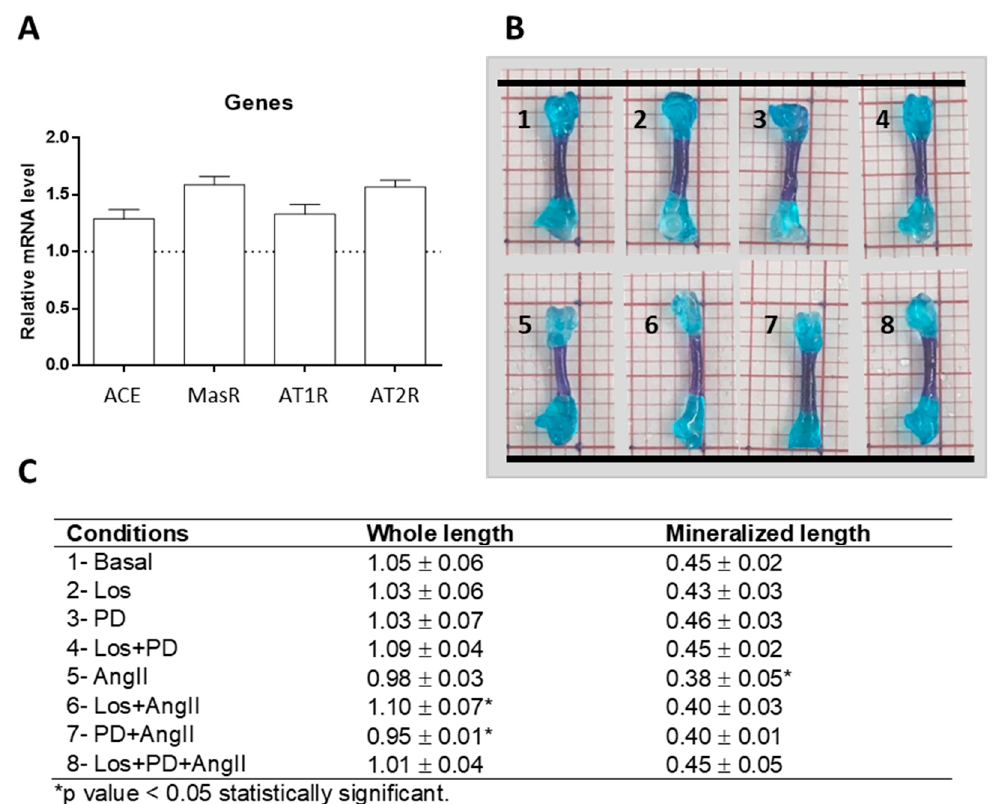
Figure 1. Gene expression (qPCR) of ACE, MasR, AT1R and AT2R of ED11 chick femurs following 11-day organotypic culture in basal conditions ( A ). Whole-mount bone and cartilage staining of chick embryos with Alcian blue and Alizarin red S ( B ). Length of the all femur and diaphyseal mineralized region ( C ).